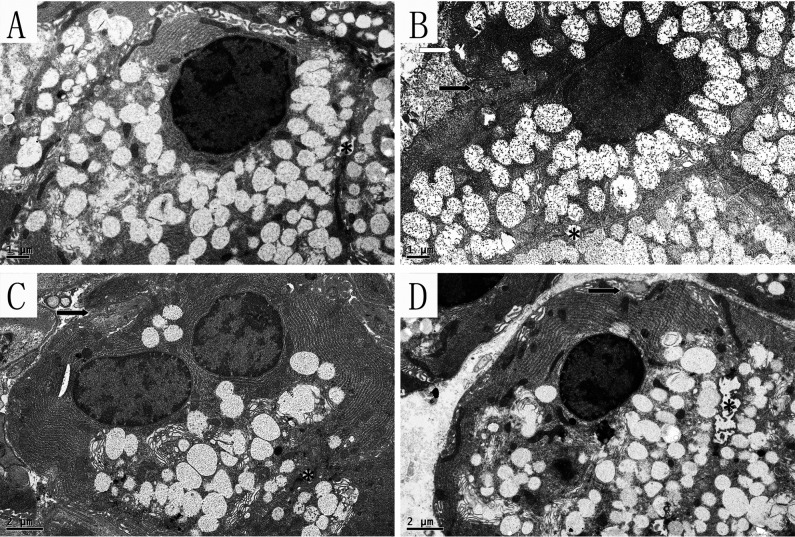
The acinar cells in the submandibular gland.A, SHAM; B, OVX; C, OVX + E; D, OVX + iCR. The scale bars in A, B represent 1μm, and in C, D represent 2 μm. The white arrow indicates the cell membrane sag, and the black arrows represent the cell membrane sag. * stand for the lumen. Compared with the SHAM group, obvious swelling occurred in the mitochondria of the OVX group with dissolution and crest fracture, but unlike the lacrimal gland, there was no obvious expansion of the endoplasmic reticulum. Moreover, the cells showed obvious atrophy with membrane sag. In the OVX + E and OVX + iCR groups, the number of mitochondrial lesions decreased, but the number of secretory granules seemed to decrease compared with the SHAM and OVX groups. The indentation of the cell membrane was improved by the two drugs.